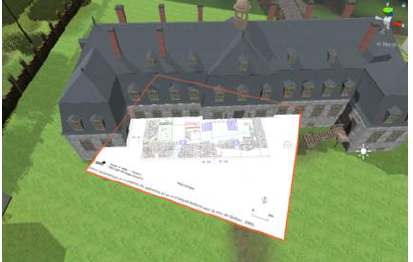
Figure 3. Archaeological excavation survey of 2009, which located the foundations of the staircase, inside the 3D virtual environment.